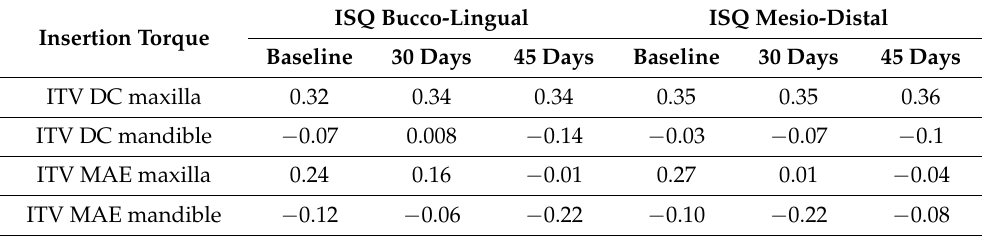
Table 3. Pearson correlation of ITV and ISQ over